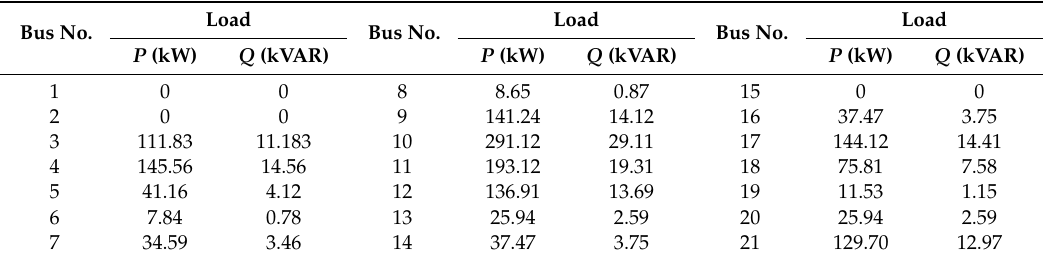
Figure 4. One-line diagram of a stand-alone microgrid in South Korea. Table 2. Load demands of “D” island.